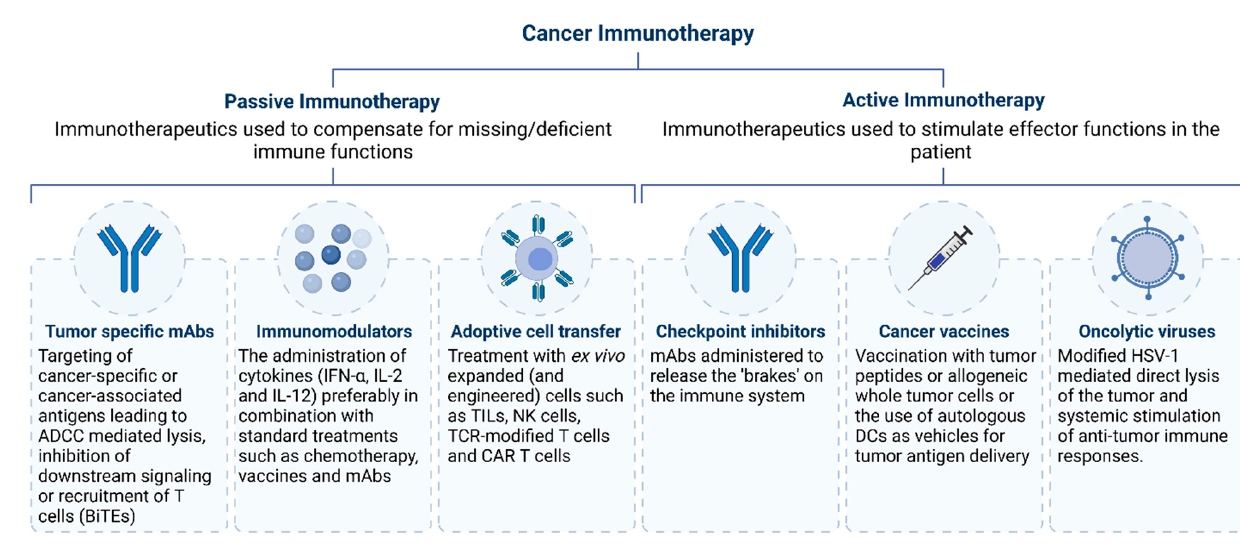
Figure 1. Overview of cancer immunotherapy approaches: ADCC: antibody-dependent cellular cytotoxicity; BiTE: bispecific T cell engager; mAbs: monoclonal antibodies; TILs: tumor-infiltrating lymphocytes; HSV-1: Herpes simplex virus-1.